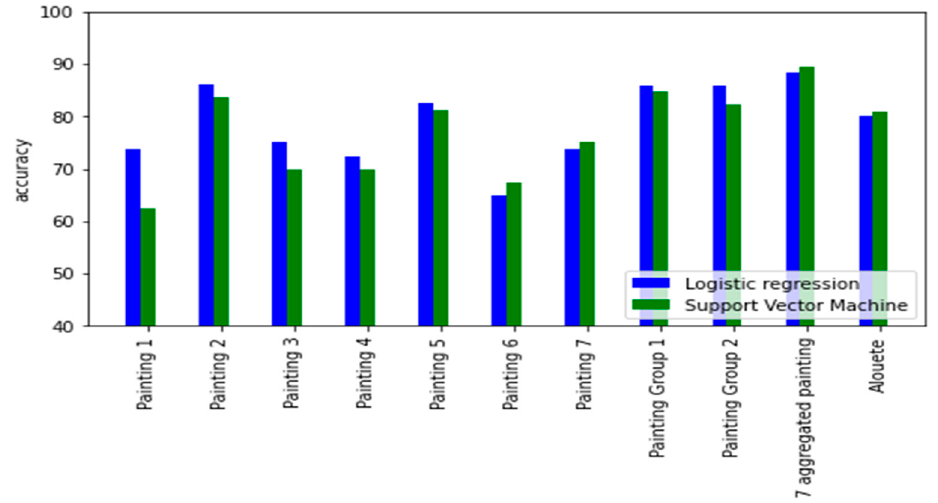
Figure 2. Pairplot of the accuracy of the Support vector machine and the logistic regression when using AIDEAL based features in analysis 1, 2 and 3.